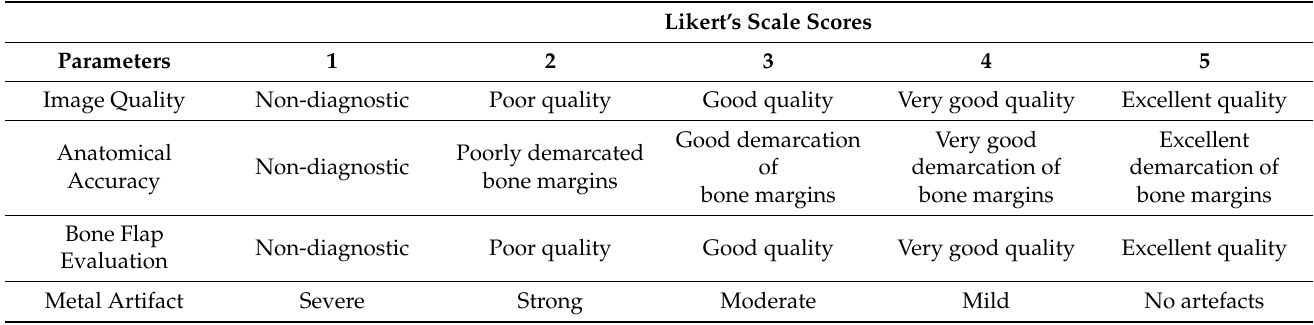
Table 2. Evaluated parameters and explanation of the 5-point Likert scale. Likert’s Scale Scores